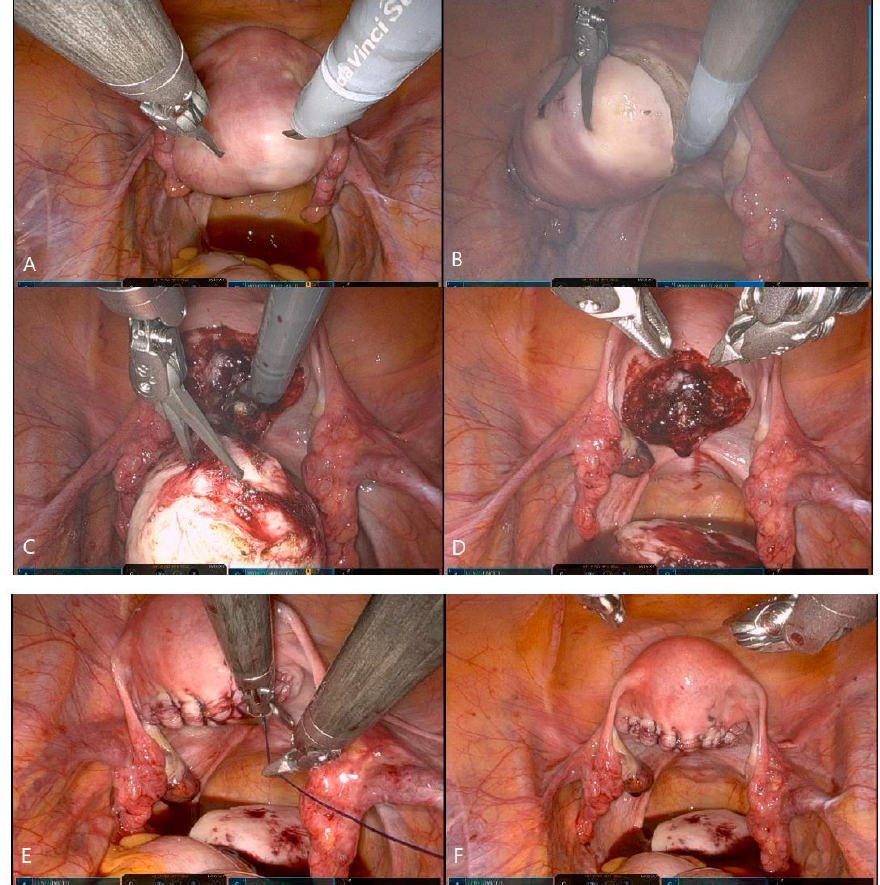
Figure 3. Myomectomy in C-RSSM; C-RSSM, coaxial-robotic single-site myomectomy. ( A ) Robotic camera view (the camera is illuminated from rear to front, from bottom to top, and the instruments are positioned relatively up front). ( B ) Within a limited range, traction and countertraction of myoma. ( C ) Myoma traction with a tenaculum grasper. ( D ) After myoma enucleation. ( E ) Suturing the uterus. ( F ) After suturing.